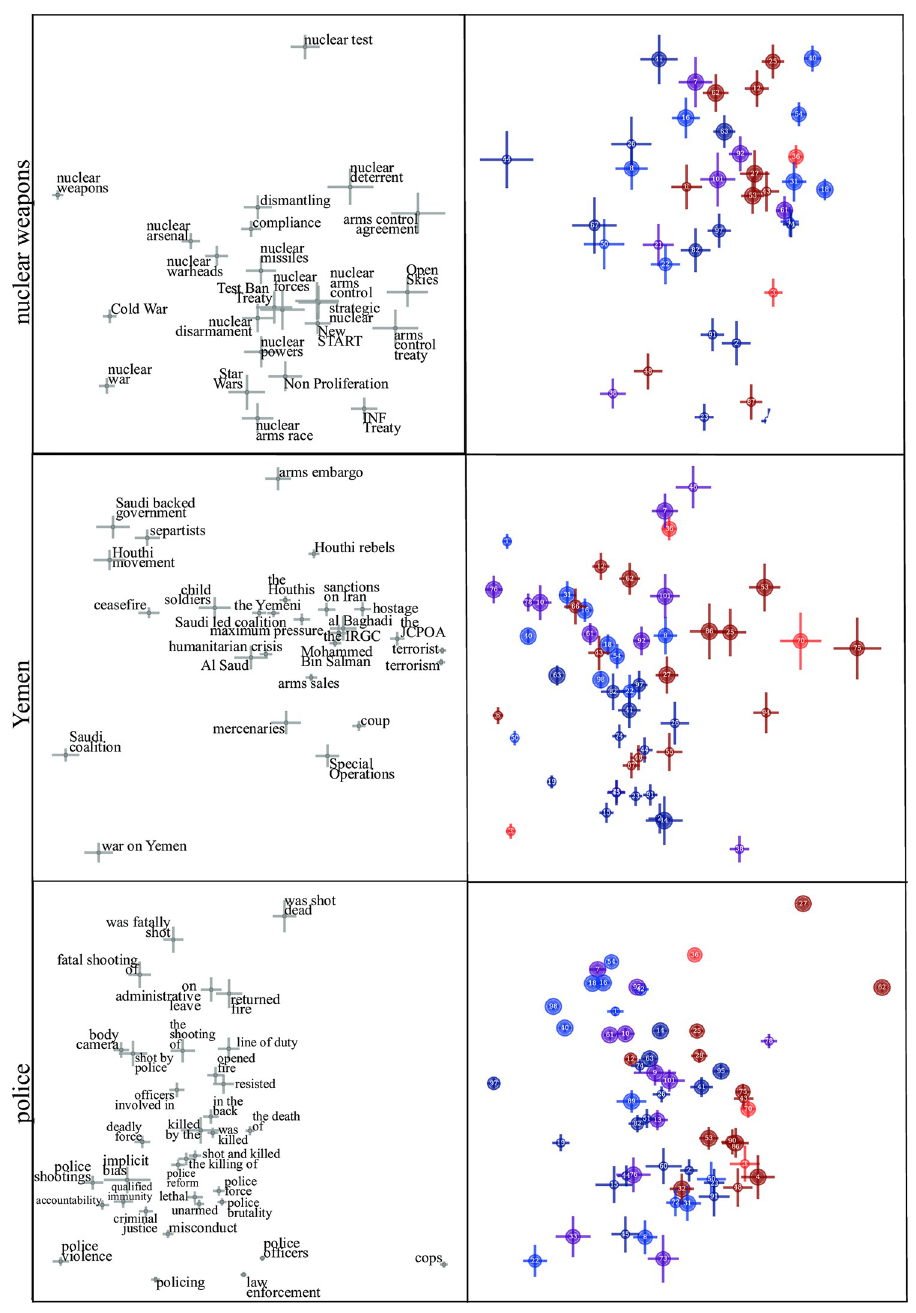
Fig 10. Establishment bias for nuclear weapons, Yemen,